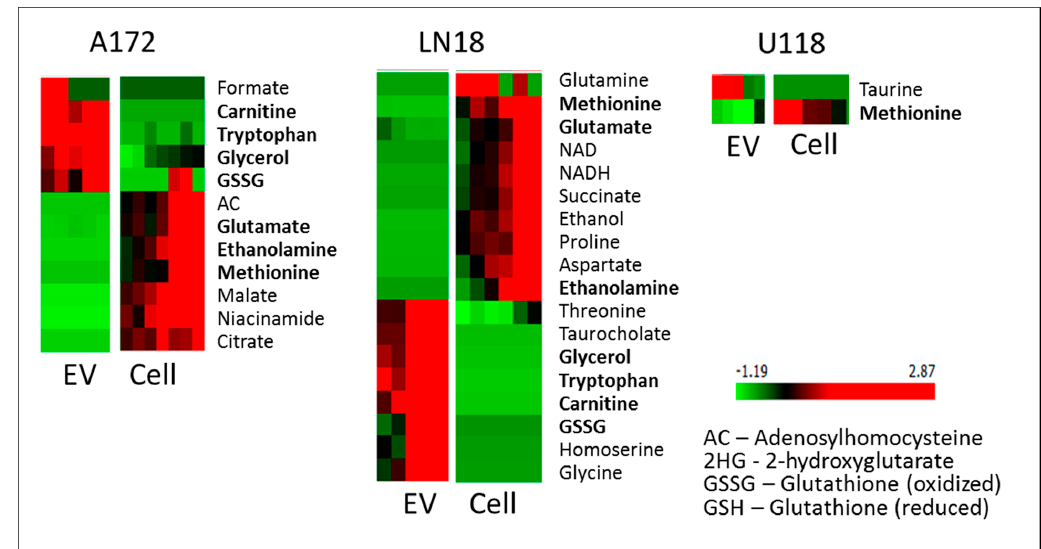
Figure 4. ANOVA selection of the most different metabolites between cell and EV extracts for GBM cell lines. Shown are metabolites with ANOVA > 5.